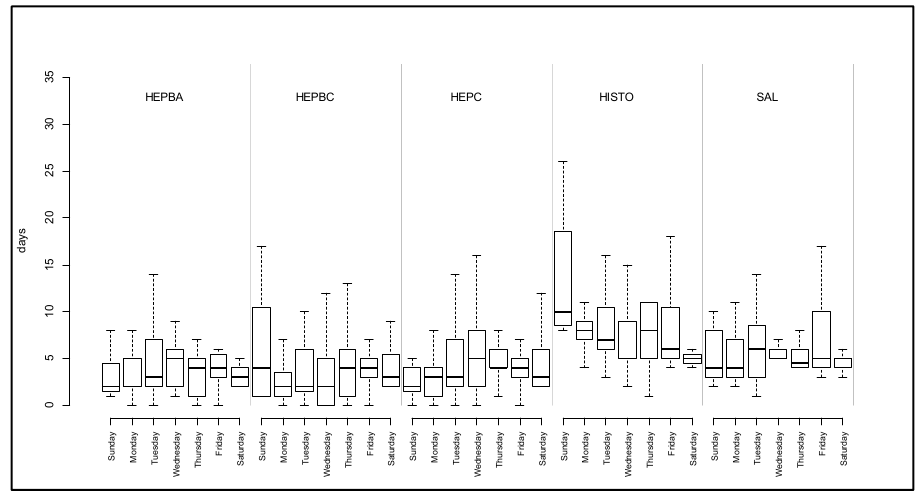
Figure 5. Time to receive case report by public health by disease and day of week, Insight DB.